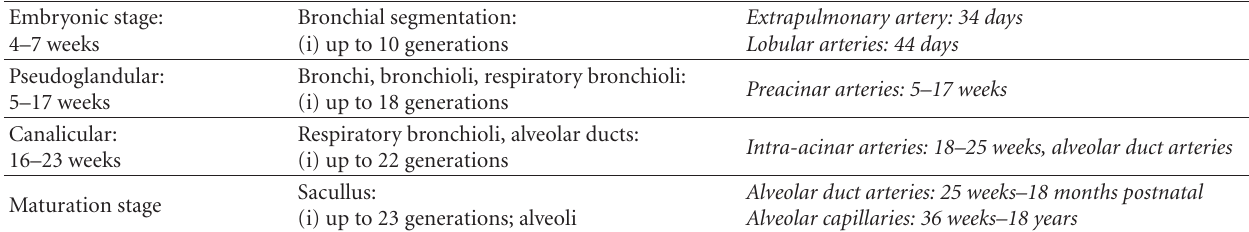
Table 1: Development of the lung (based on Hislop [2]).